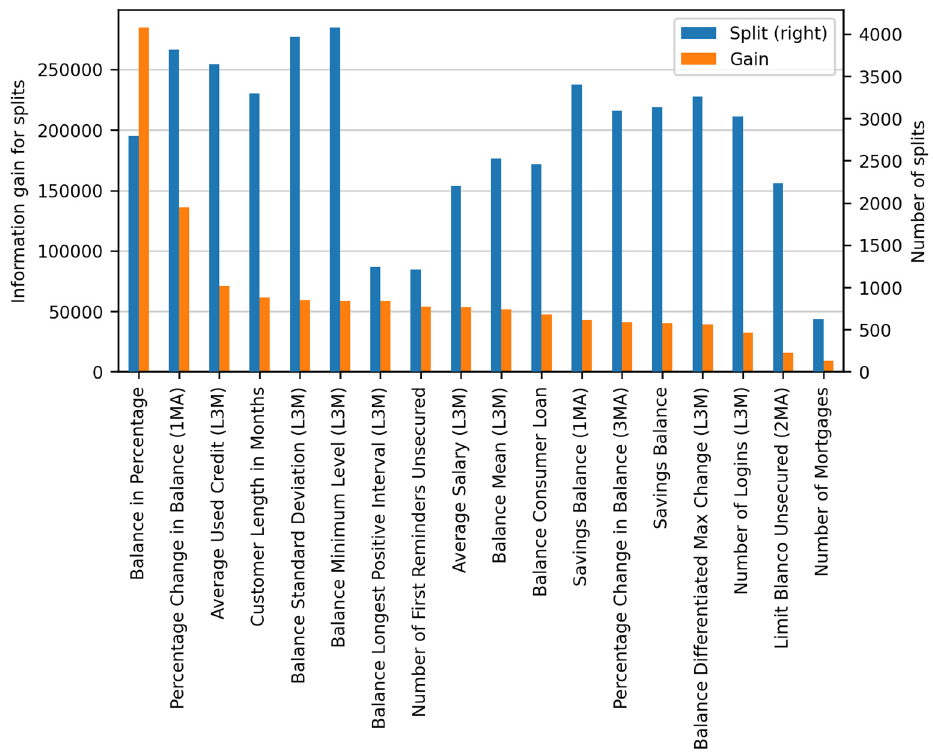
Figure 5. Feature importance according to the LightGBM model. Average values across the 10 models from the stratified cross-validation, ranked by information gain. The number of splits on the right y -axis, and corresponding information gain for splits on the left y -axis.